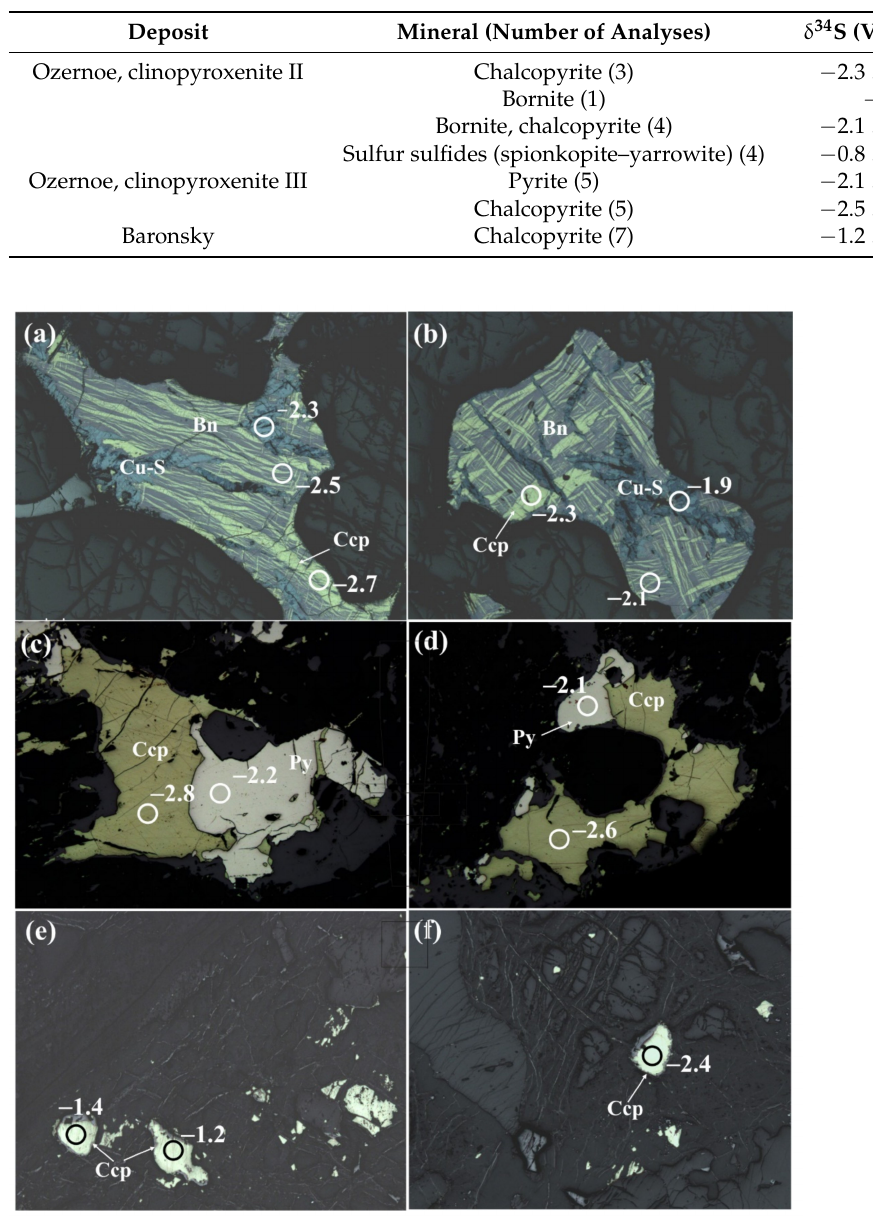
Figure 13. Sulfur isotopic composition of sulfides from Ozernoe ( a – d ) and Baronsky ( e , f ) deposits. Sites of analysis are shown by circles with a diameter 100 µ m, numbers show δ 34 S values in